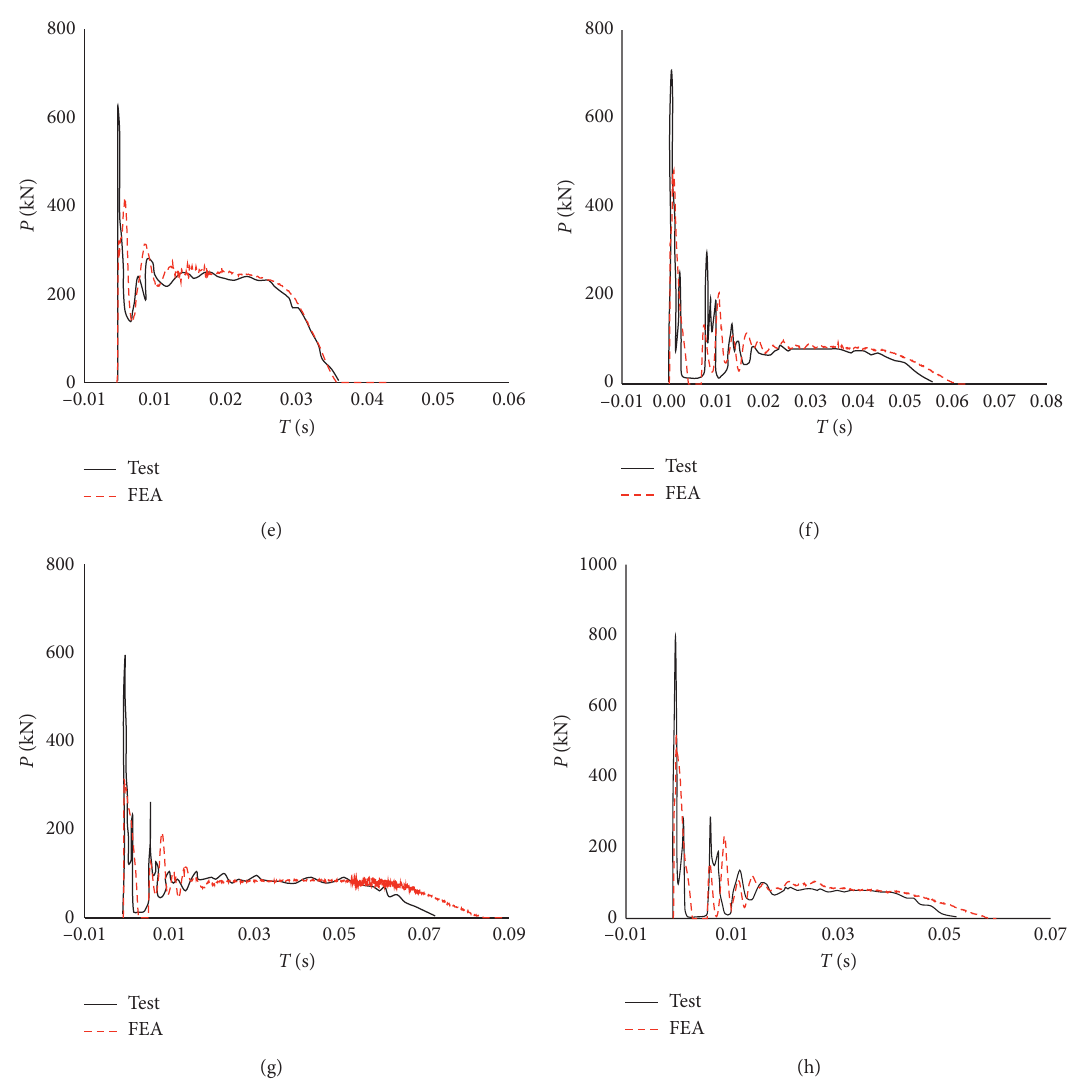
Figure 3: Impact force ( P ) versus time ( T ) curves. (a) MSH, (b) Pd1, (c) Pd2, (d) CC1, (e) CC2, (f) SS1, (g) SS2, and (h) SS3.